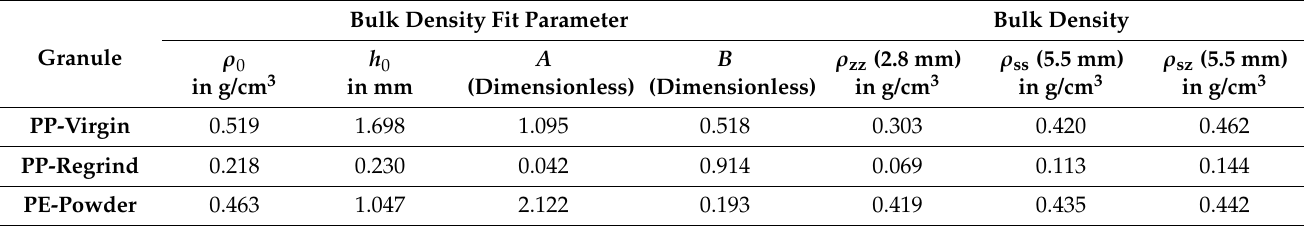
Table 2. Geometrical dimensions of the utilized screw and of the helically and the axially grooved barrel (data from [28]).